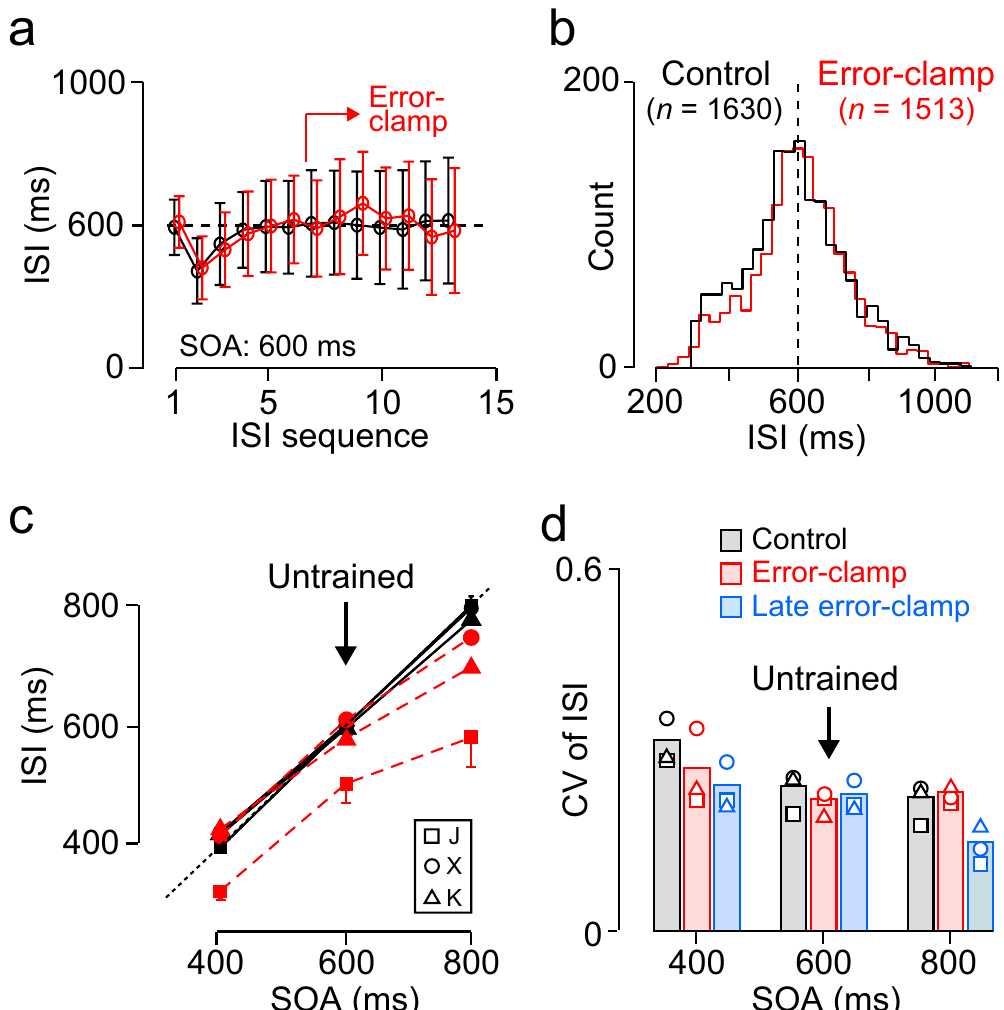
Figure 4. Entrainment to periodic stimuli. ( a ) Inter-saccadic intervals (ISIs) are plotted as a function of saccade sequence for 5 experimental sessions in monkey X. In the error-clamp trials (red), the target appeared when the monkey looked at the target location ( ≥ 7th saccade in the sequence). Error bars indicate ± SD (inter-trial variation). ( b ) Distributions of ISIs for the 7–12th saccades (clamp period) in trials with (red) and without (black) error-clamp. ( c ) The ISIs as a function of SOA in the error-clamp (red dashed lines) and non-clamp (control) conditions (black solid lines) for different animals. Error bars indicate SDs of 5 experimental sessions and are shown only for some data points. ( d ) Coefficient of variation (CV) of ISI for different SOAs. Each data point shows the mean of 5 sessions for each monkey. Blue bars indicate the data during the late part ( > 2000 ms) of error-clamp